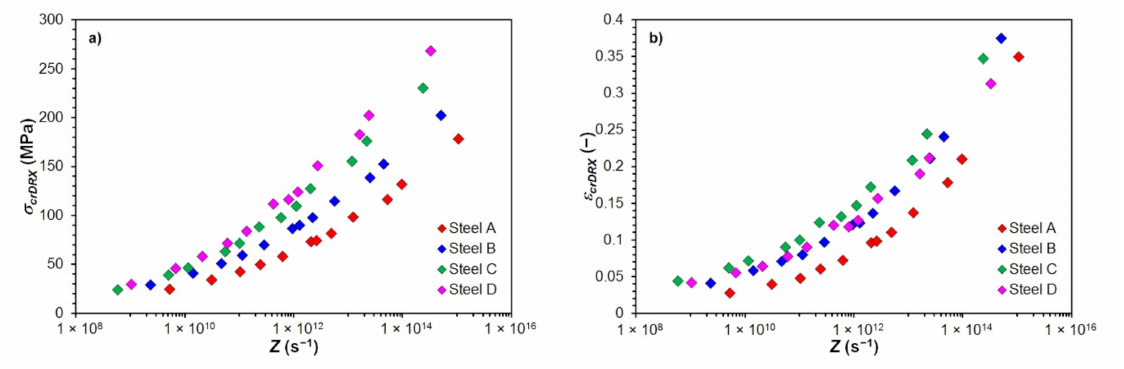
Figure 13. The effect of Zener–Hollomon parameter Z to determined critical stresses σ crDRX and critical strains ε crDRX for induce of dynamic recrystallization of investigated steels: ( a ) critical flow stress σ crDRX ; ( b ) critical strain ε crDRX